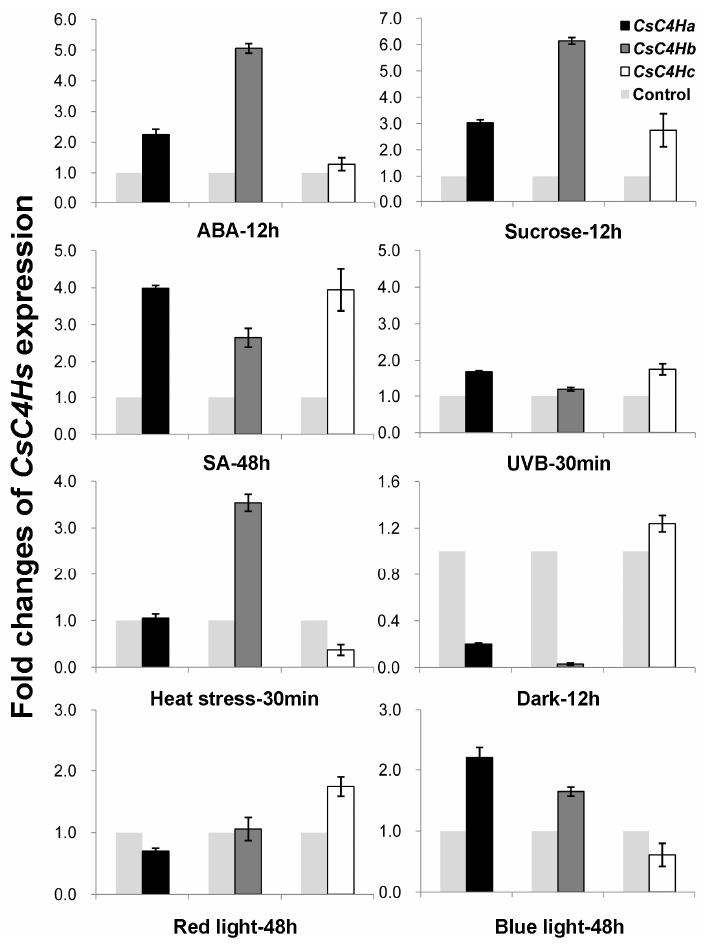
Figure 6. The transcript levels of CsC4Hs under different abiotic stresses. ABA: abscisic acid; SA: salicylic acid; UVB: ultraviolet radiation b.